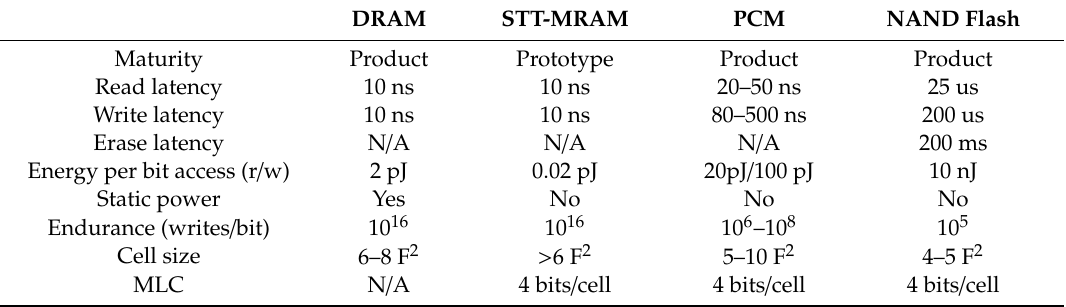
Table 1. Characteristics of non-volatile memory (NVM) technologies in comparison with dynamic random access memory (DRAM) and NAND flash